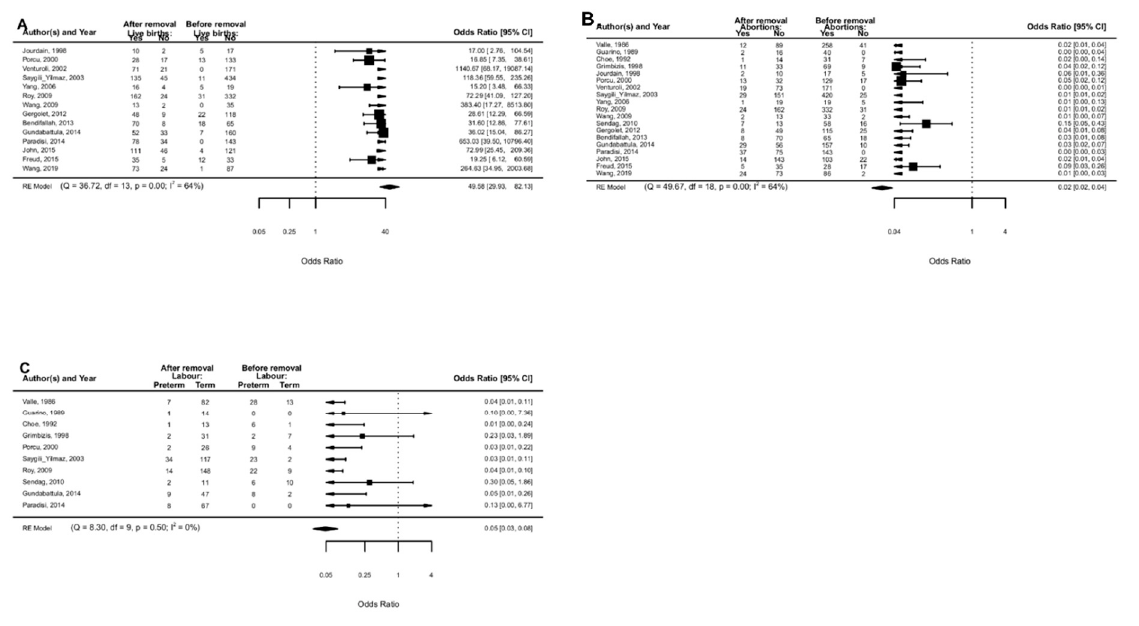
Figure 4. Before vs. after septum removal: live birth rate ( A ), spontaneous abortions in I-II trimesters ( B ), and preterm labour ( C ).